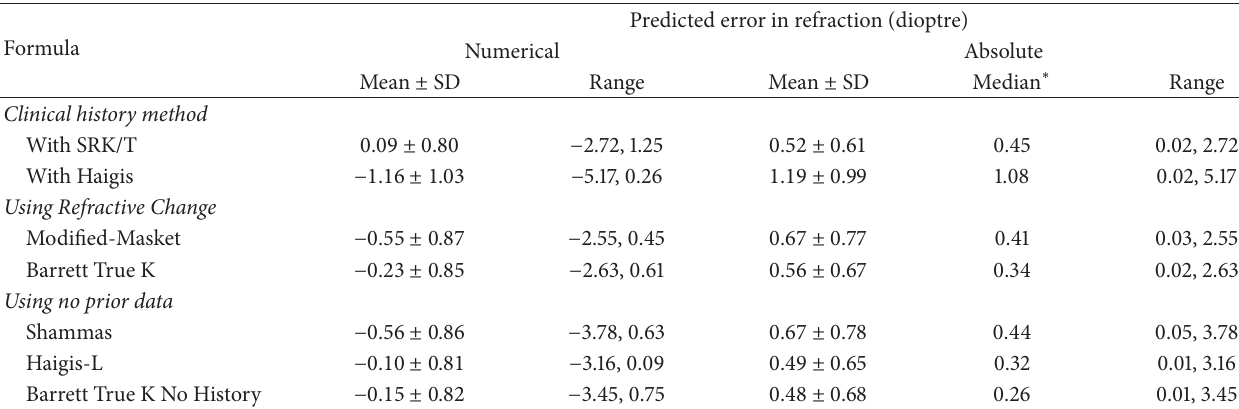
Predicted error in refraction (dioptre)